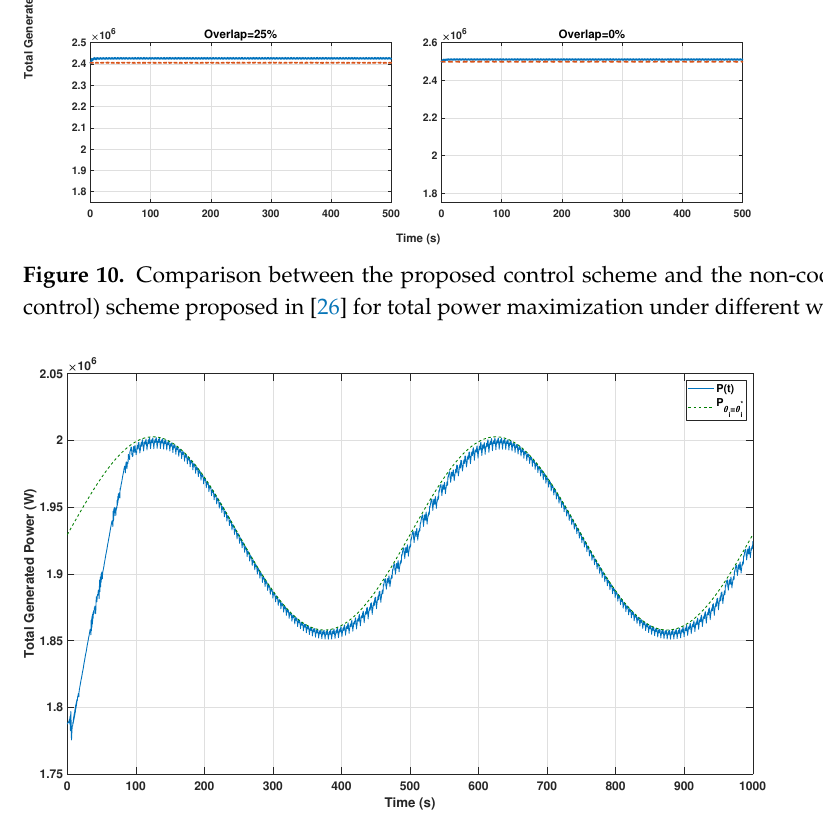
Figure 11. Successful tracking of optimal production under varying free stream wind